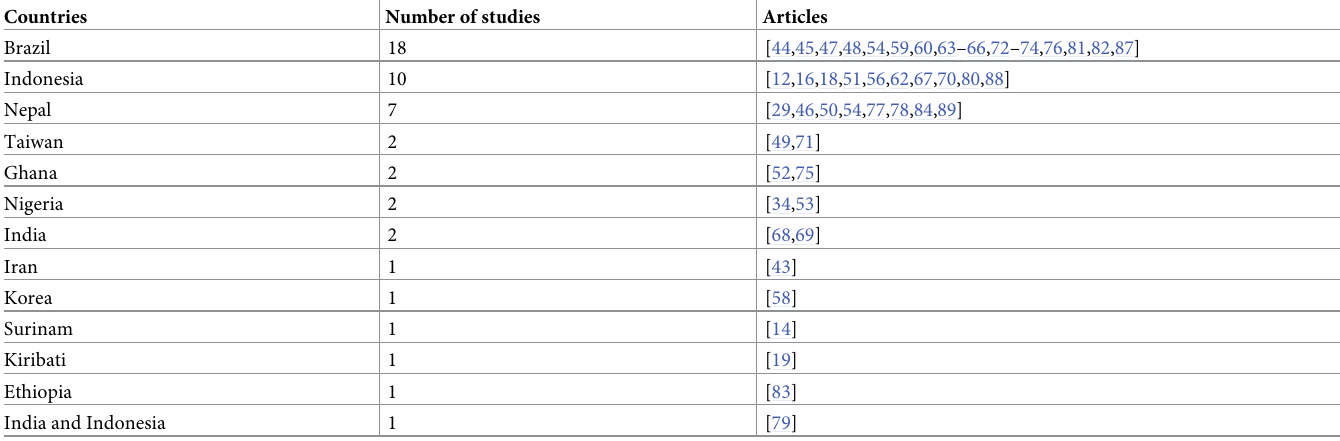
Table 2. Countries of origin of included